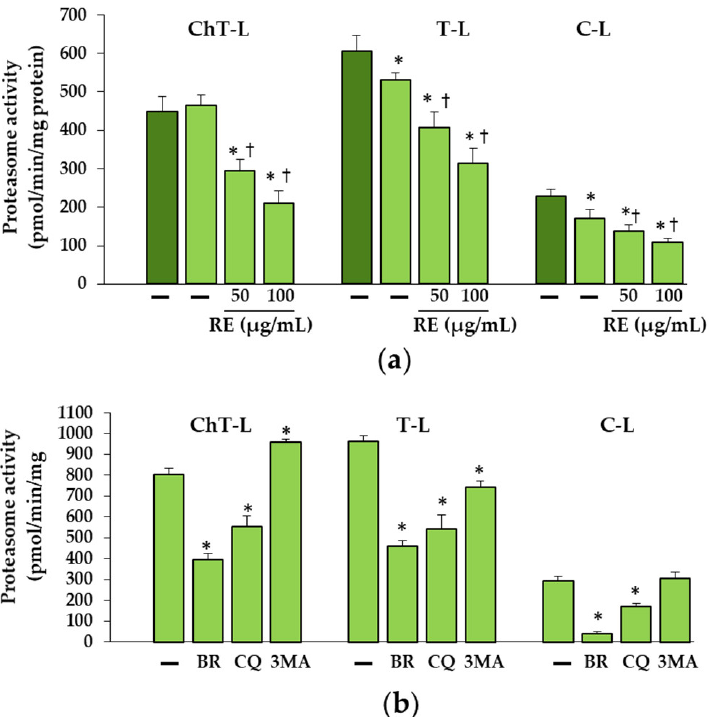
Figure 8. Proteasomal activities: chymotrypsin-like (ChT-L), trypsin-like (T-L) and caspase-like (C-L) in OI III 2 cells treated with 50 and 100 µg/mL rosemary extract (RE) ( a ), 5 nM bortezomib (BR), 50 µM chloroquine (CQ) and 5 mM 3-methyladenine (3-MA) ( b ). The bars represent the mean values from three independent experiments. ( a ) * p < 0.05, OI cells vs. normal cells; † p < 0.05, OI cells treated with RE vs. OI untreated cells; dark green and light green bars represent normal and OI, respectively; ( b ) * p < 0.05, OI cells treated with inhibitors vs. OI untreated cells.